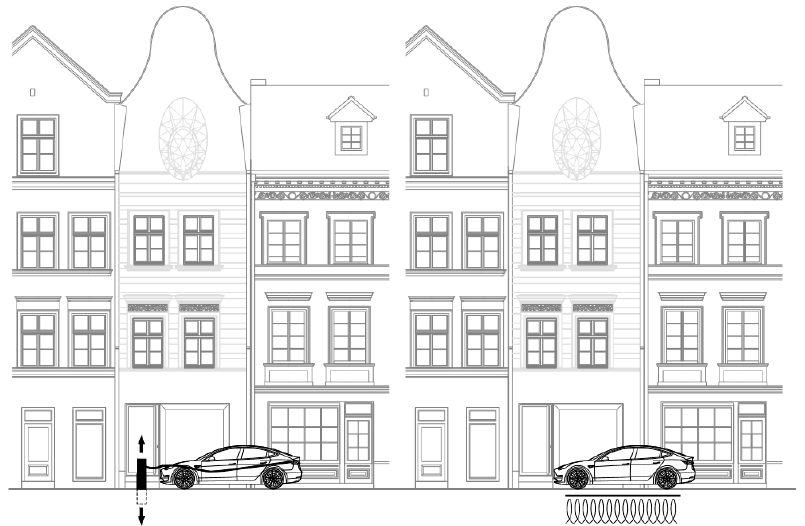
Figure 22. Proposals of integrating EV charging stations (on the left: charging with the use of connection; on the right: inductive charging; proposals taking into account solutions by WiTricity and Urban Electric [56,57]).